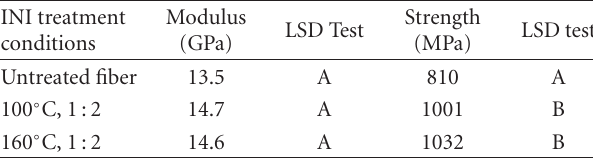
Table 3: Tensile properties of individual